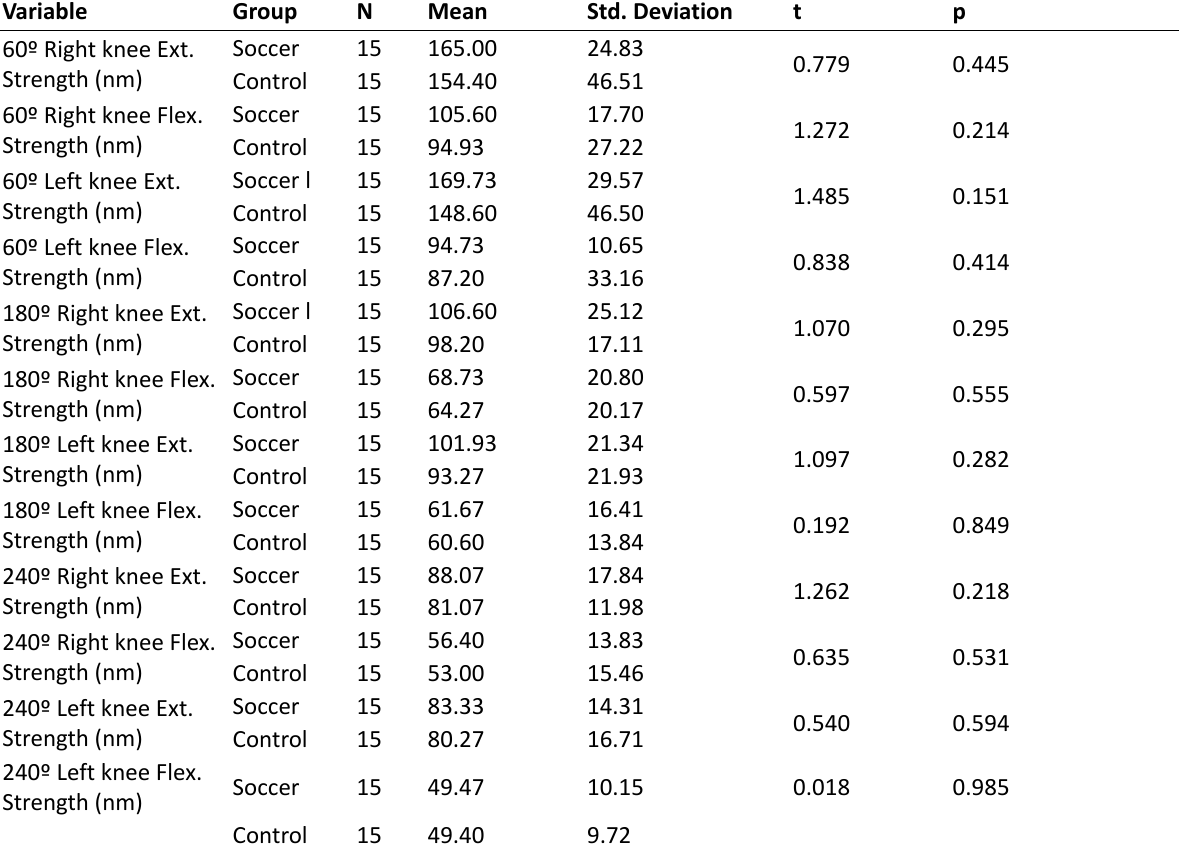
Table 3. Comparison of isokinetic knee strength parameters of the football and the control group